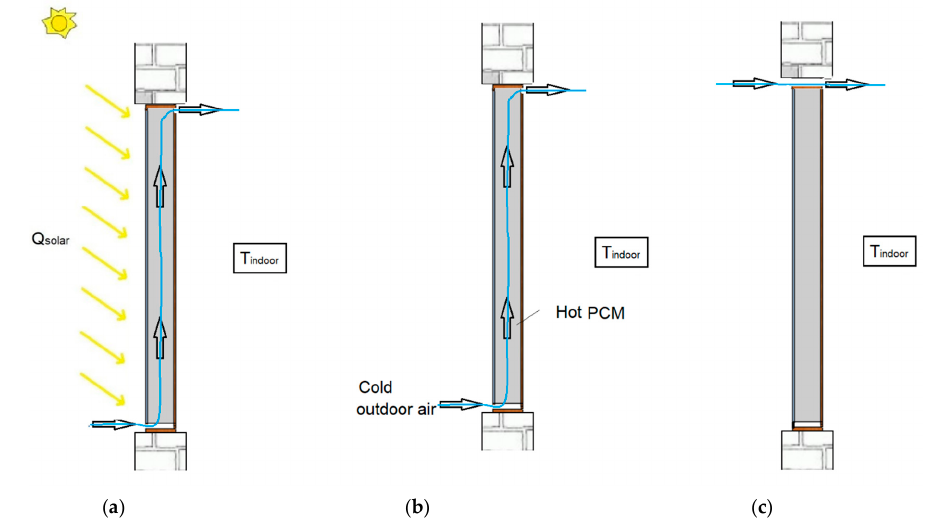
Figure 6. The working principle of the PCM façade in winter. (a) Heat storage mode, when I > 200 W/m 2 ). (b) Heat release mode, when T indoor < 24 °C . (c) Bypass ventilation mode, when T indoor >= 24 °C .